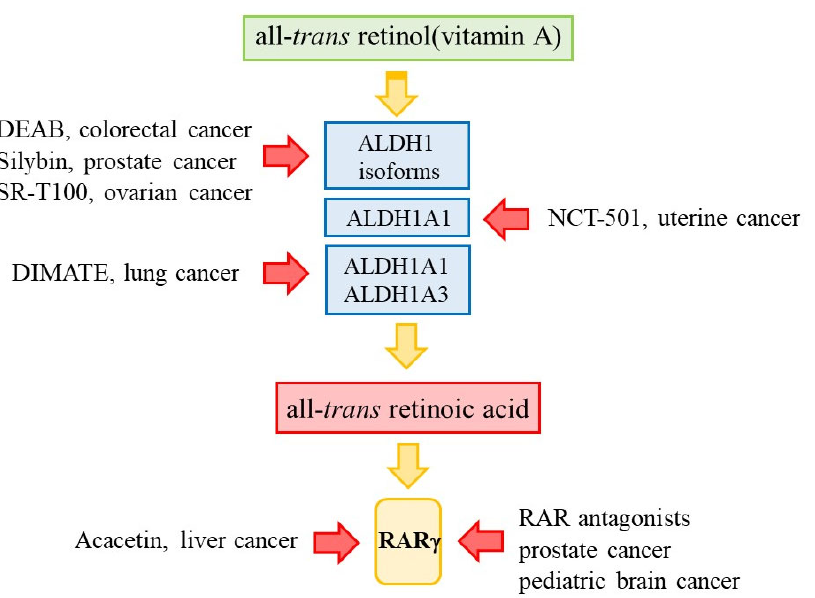
Figure 5. Targeting the retinoic acid pathway. Preventing the action of RAR γ is druggable by either targeting the enzymes that generate a supply of ATRA or by blocking the action of RAR γ . Aside from the uncertainty regarding the upregulation or downregulation of ALDHs, the rationale for targeting to eradicate CSCs is that expression marks the clono ‐ genicity and metastatic capacity of CSCs in colorectal cancer [73] and esophageal squa ‐ mous cell carcinoma [74]. ALDH1A1 expression maintains the properties of squamous cell carcinoma CSCs by enhancing clonogenicity, the ability to generate spheroids in vitro, and tumorigenicity in vivo [75]. High ALDH activity identifies prostate cancer CSCs that are metastasis ‐ initiating [76]. For non ‐ small cell lung cancer primary cells and cell lines, high ALDH activity correlates with a poor prognosis. Notch signalling maintains ALDH+